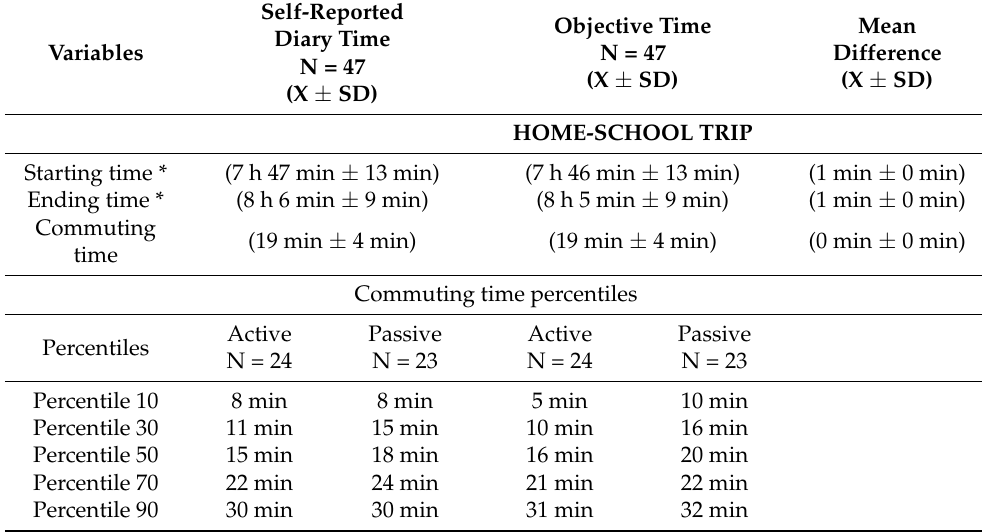
Table 1. Descriptive characteristics of home–school and school–home